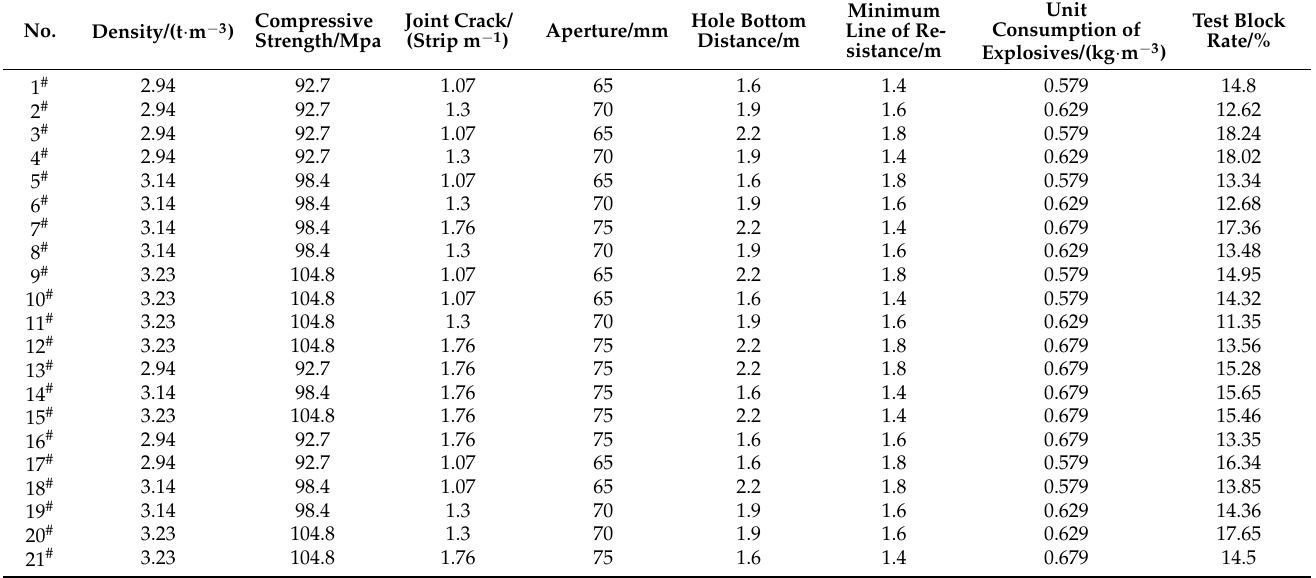
Table 6. Field orthogonal experimental